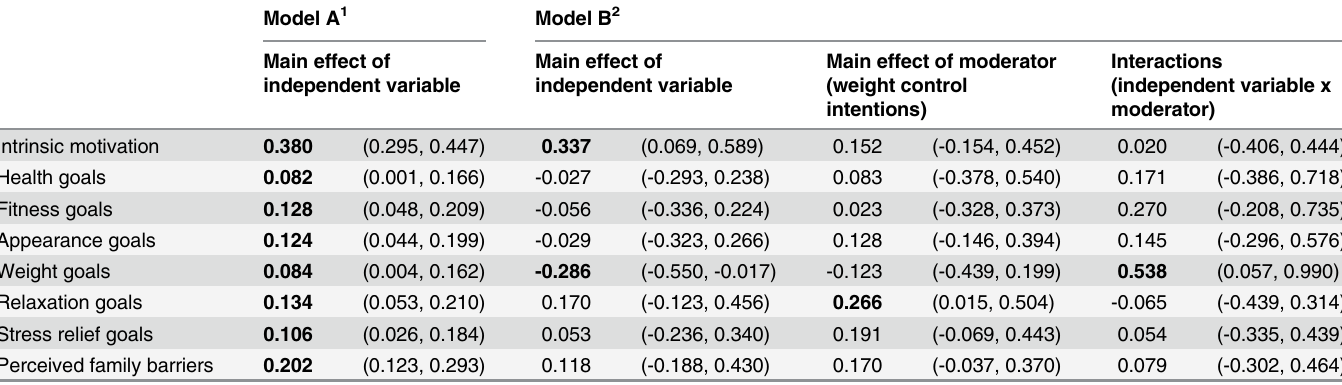
Table 2. Associations between physical activity motivation and barriers and leisure-time physical activity at baseline, and moderator effects of weight control